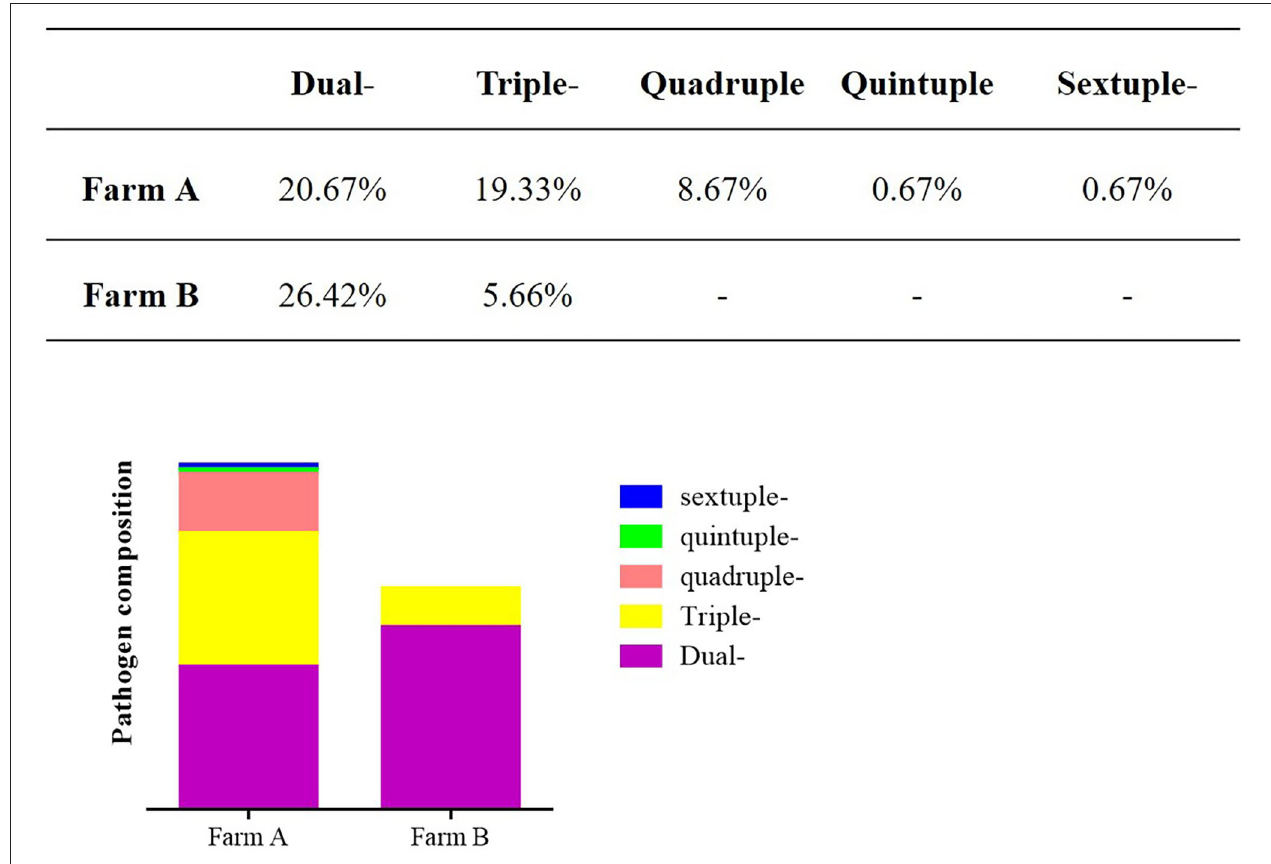
FIGURE 6 | The co-infections of different farms. Different co-infections were analyzed in different